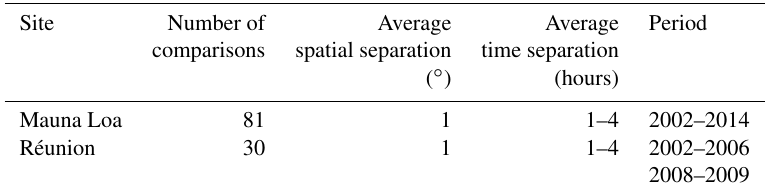
Table 2. Characteristics of SABER–lidar comparisons. No temperature profiles were recorded at Réunion during 2007 because of technical problems with the Rayleigh lidar system.